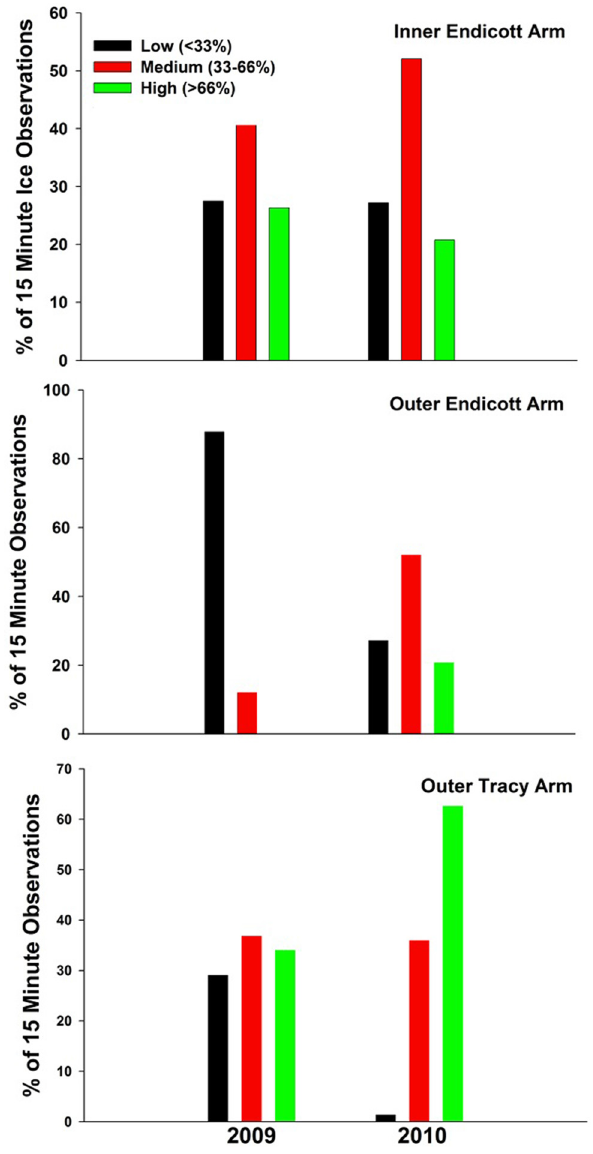
Fig 3. Percent ice coverage. The percent of all 15 minute observation periods in which three categories of ice coverage were observed in 2009 and 2010 for all three remote monitoring sites in the study area. The percentage of the area covered by icebergs within each time-lapse photograph was estimated and categorized in thirds, as low ( < 33% ice coverage), medium (33 – 66%), and high ice coverage ( >